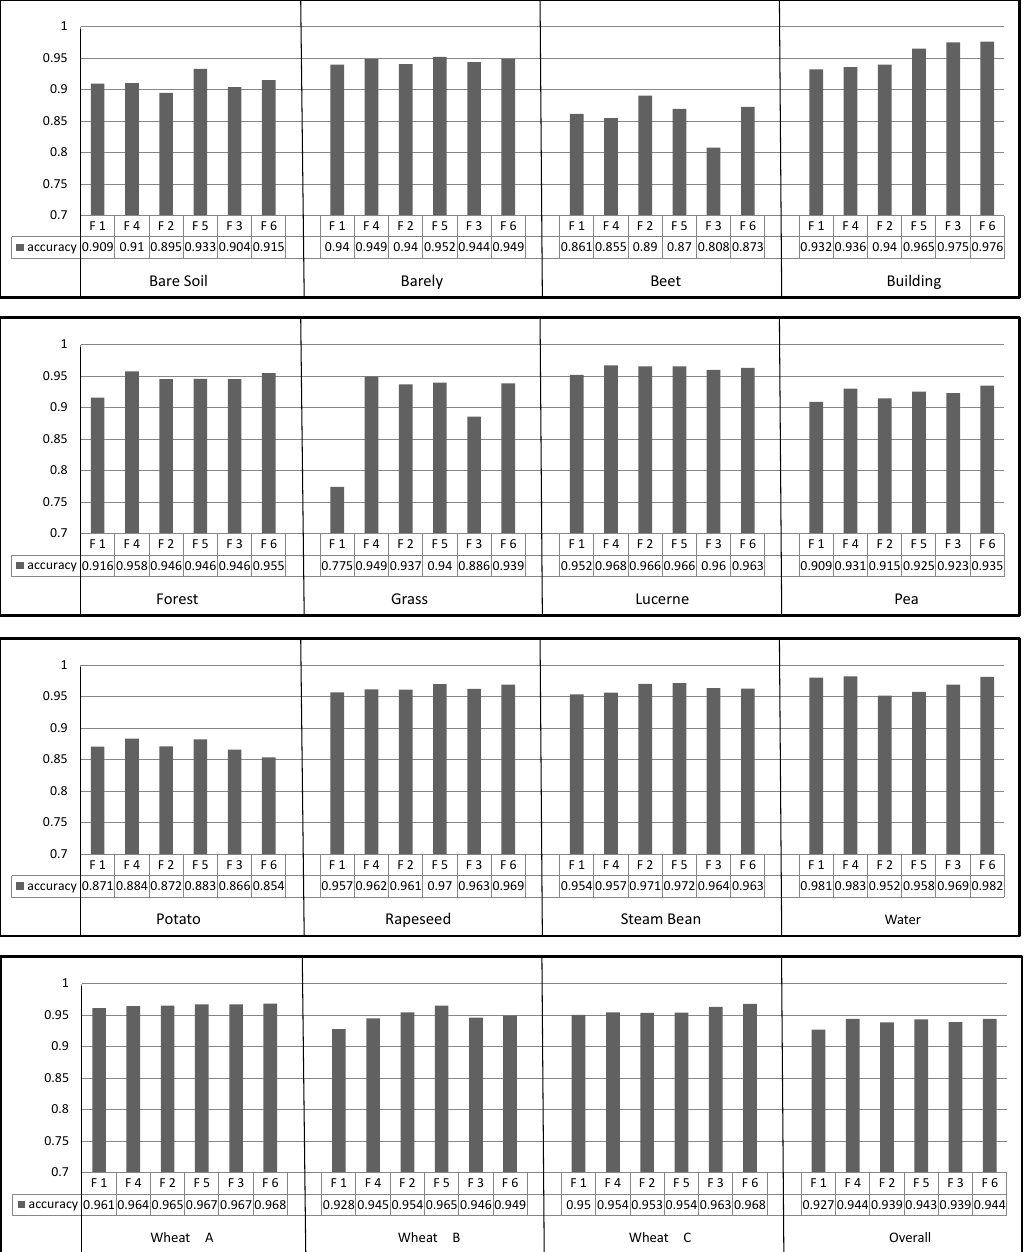
Figure 14. The classification accuracies of each class and the overall image using different features for the Flevoland